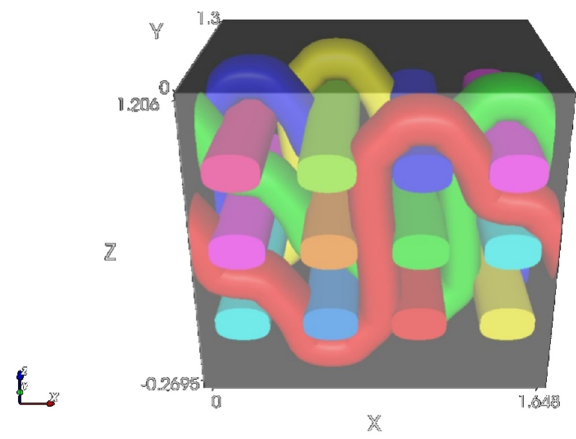
Figure 4. Weave unit simulation in Texgen.